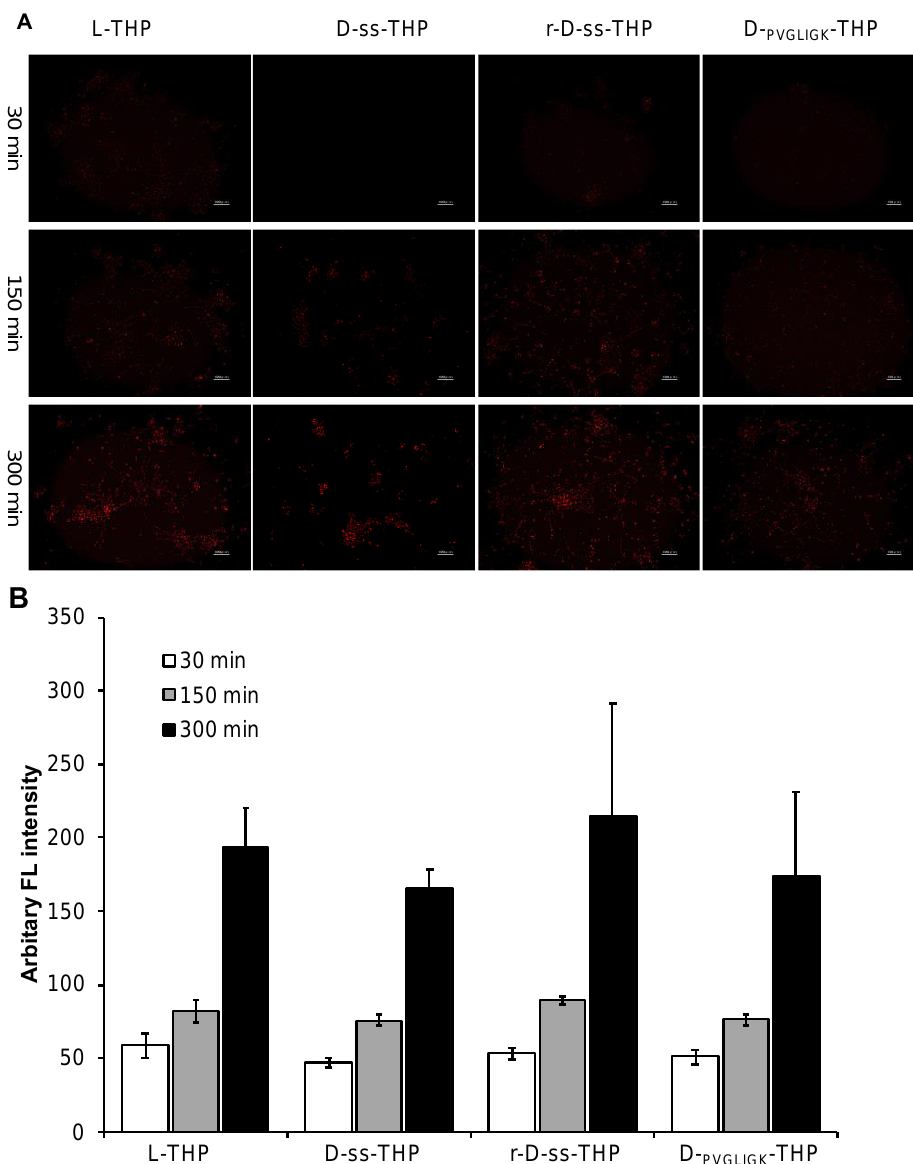
Figure 6. Intracellular uptake of different P-THP conjugates in C26 cells. C26 cells were cultured in 12-well plates to which different P-THP conjugates were added. After a scheduled time, the internalized drugs were visualized by fluorescence microscopy ( A ) and quantified by fluorescence spectroscopy ( B ). Data are mean ± SE. See text for